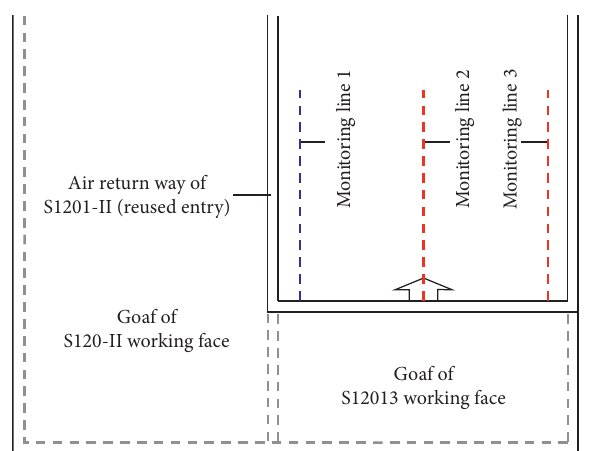
Figure 7: Stress distribution monitoring position in front of the working face.